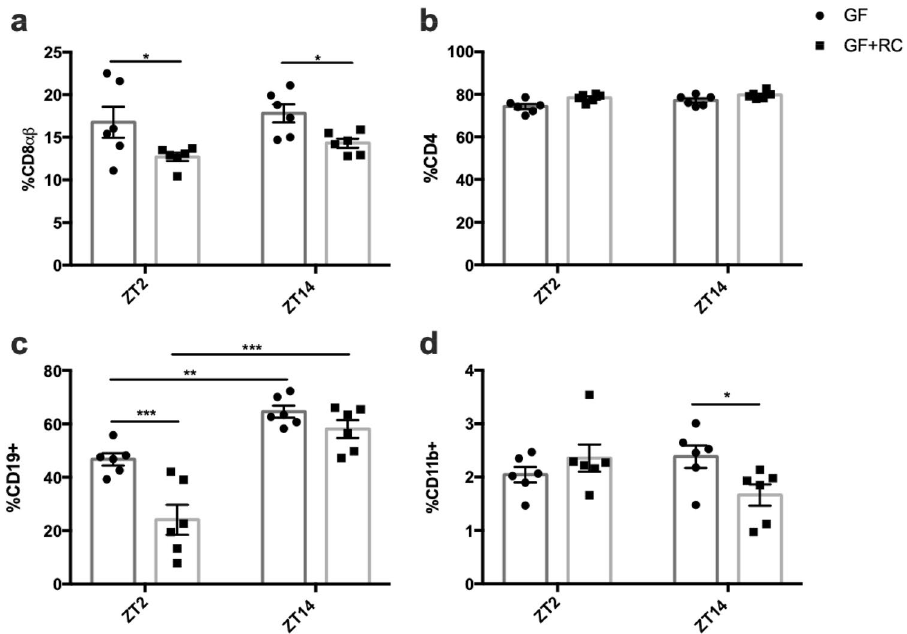
Figure 8. FMT in GF-mice alters proportion of CD8αβ + but not CD4 + SI LPL cell populations. Proportions of ( a ) CD8αβ + and ( b ) CD4 + on TCRβ + cells, as well as ( c ) CD19 + B-cells and ( d ) CD11b + myeloid cells acquired from the SI lamina propria at ZT2 and ZT14 from GF and GF-mice following FMT with RC-microbiome. n = 2–3 male and 2–3 female mice. * p <